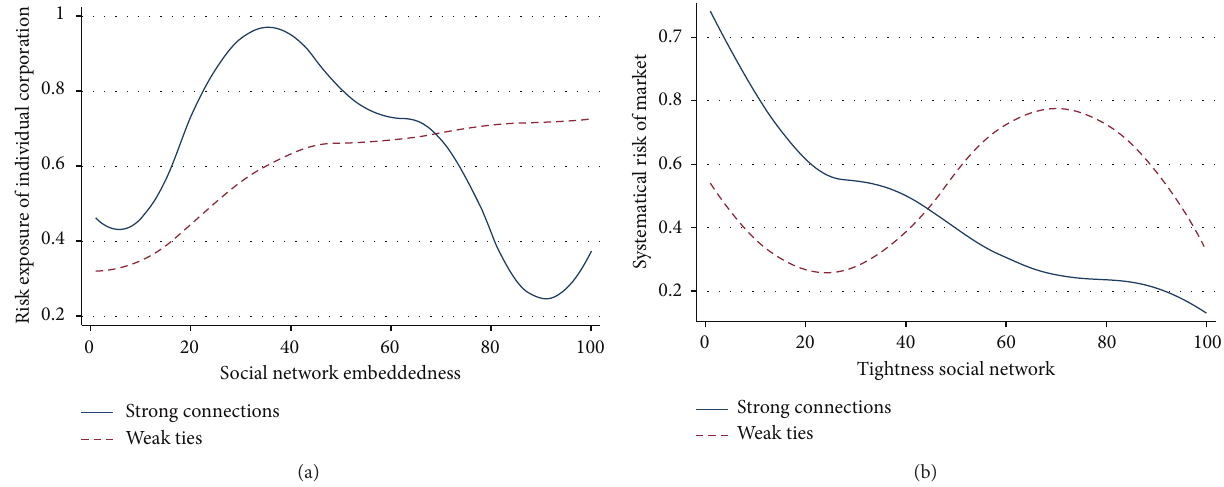
Figure 4: Social networks and risk contagion consequences. (a) Risk exposure of individual corporation. (b) Systematical risk of